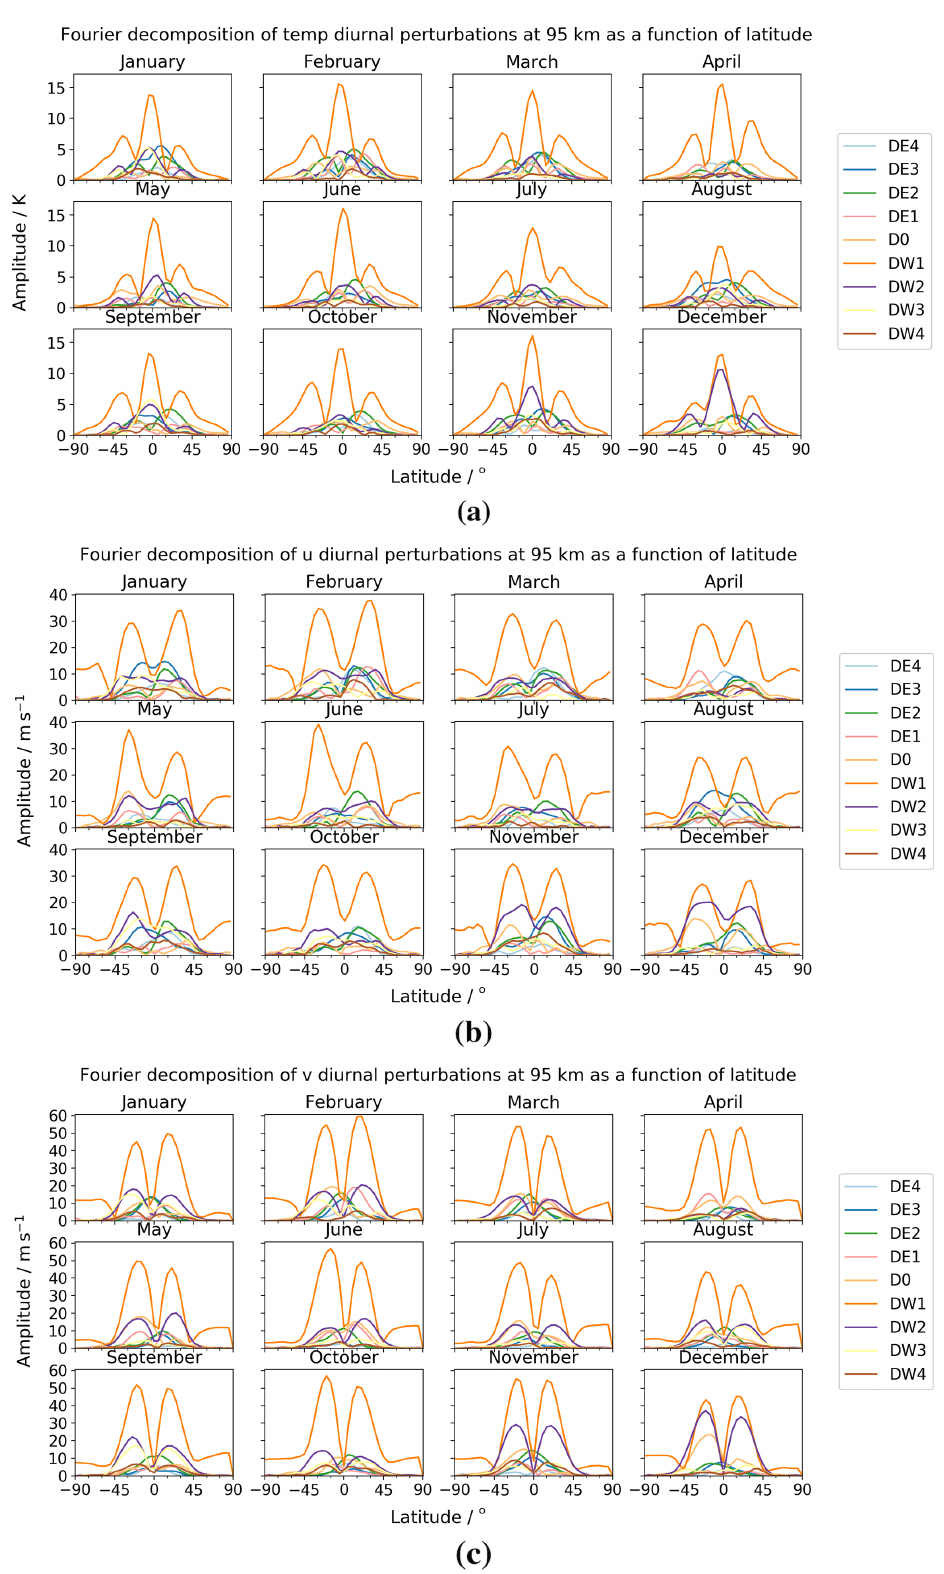
Figure 12. Latitude–amplitude plot of diurnal tidal amplitudes across the year for (a) temperature, (b) zonal ( u ) winds, and (c) meridional ( v )